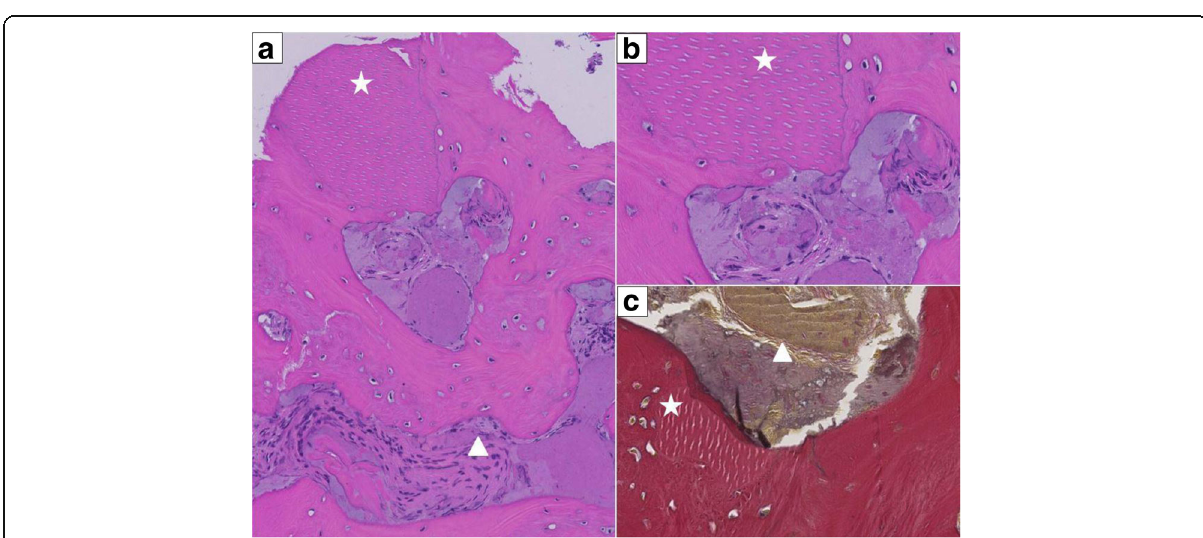
Fig. 17 Histology of dentin augmentation. a Asterisk denotes incorporated dentin particle, surrounded by vital woven bone. Triangle shows reactive process in the bone marrow lacunae with osteoblast rimming. No signs of necrosis or infection (H&E stain, ×100 magnification). b Larger magnification at ×200. c EvG (Elastica van Gieson) stain, ×200